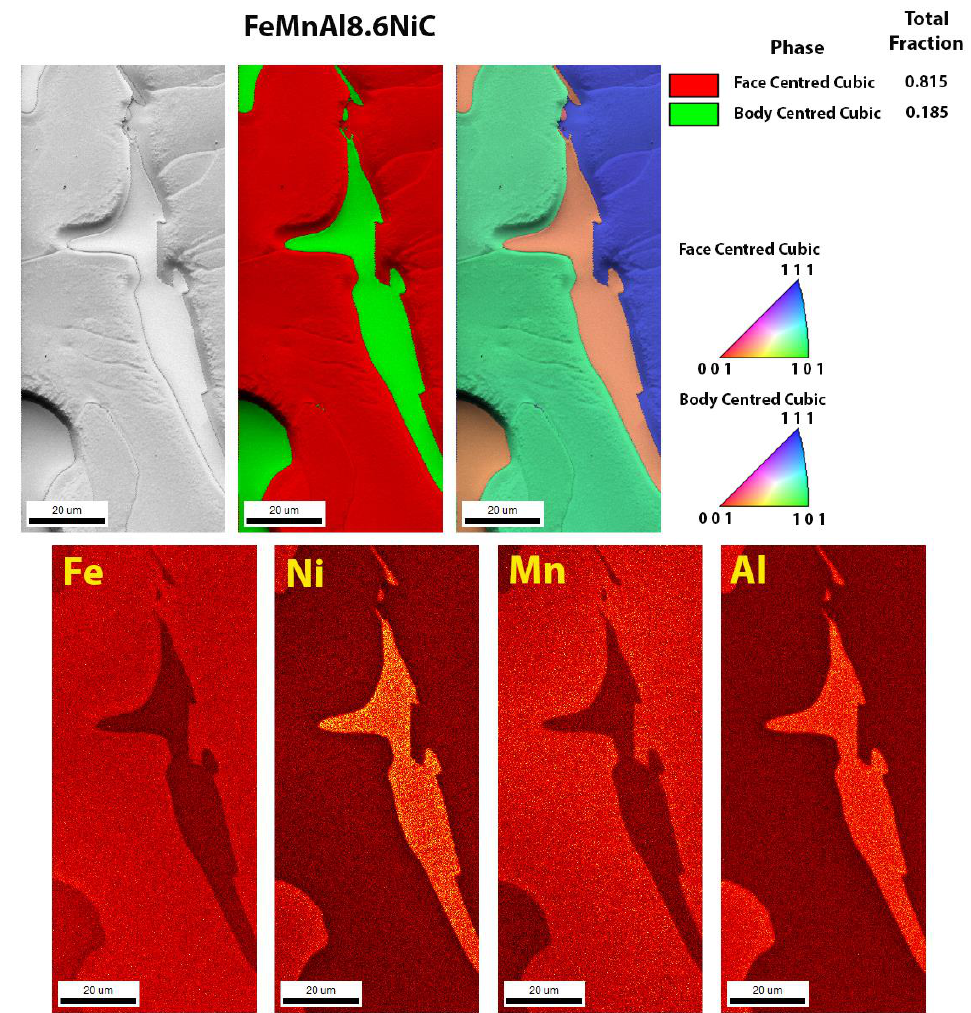
Figure 11. Electron backscattered diffraction analysis of a sample as-cast FeMnAl8.6NiC sample and SEM EDS (Energy- dispersive X-ray spectroscopy) elemental mapping of Fe, Ni, Mn, and Al.